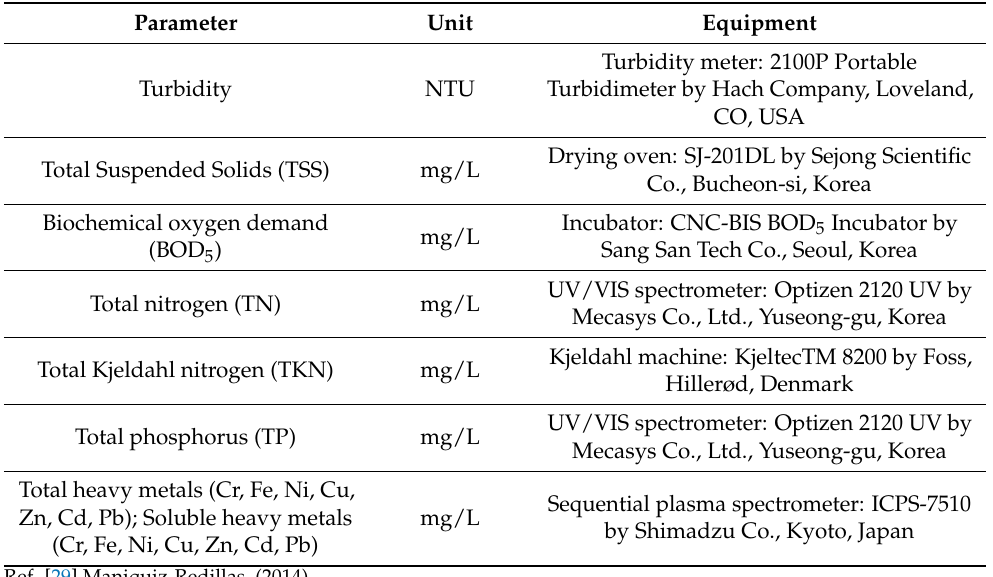
Table 1. Parameters determined and equipment used in the study.